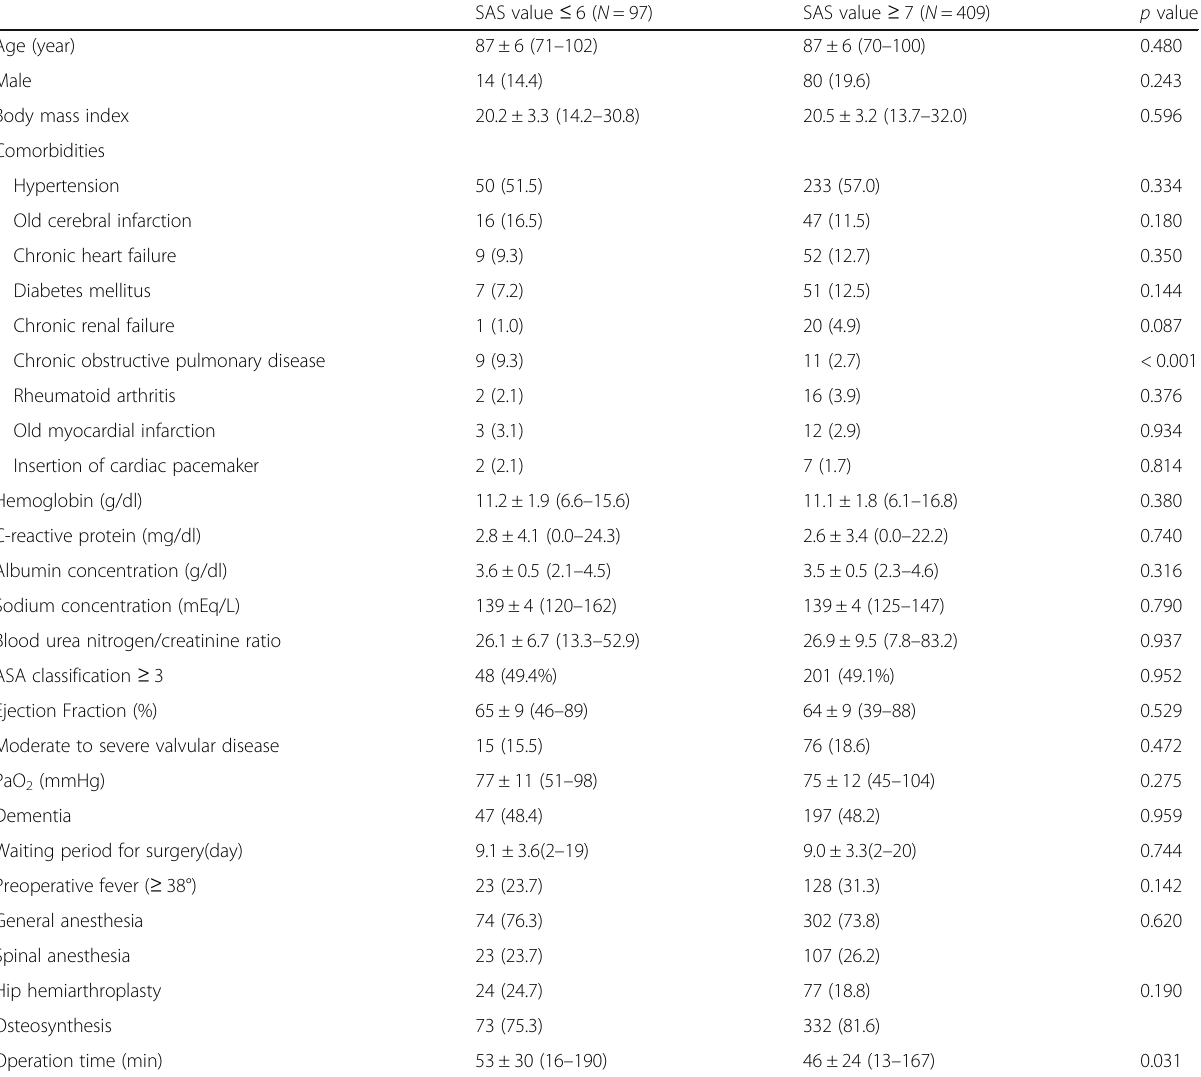
Table 5 Comparison of clinical characteristics between the SAS value ≤ 6 and SAS value ≥ 7 patients SAS value ≤ 6 ( N =